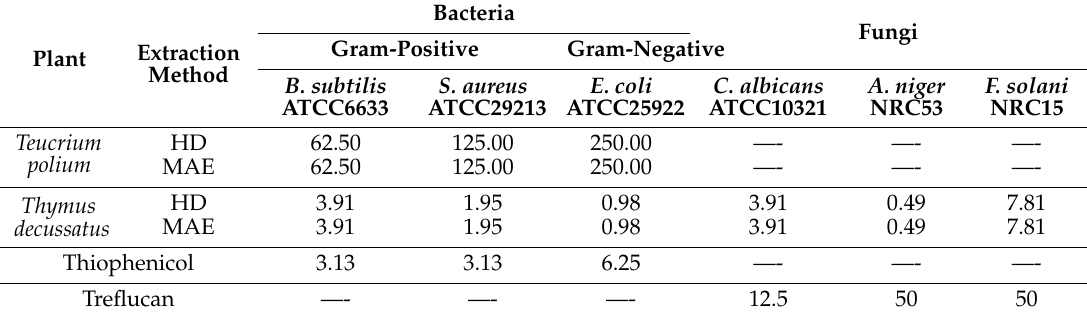
Table 4. Minimum inhibitory concentrations (MICs) in µ g / mL of the EOs extracted using hydrodistillation (HD) and microwave-assisted extraction (MAE) methods against di ff erent bacterial and fungal